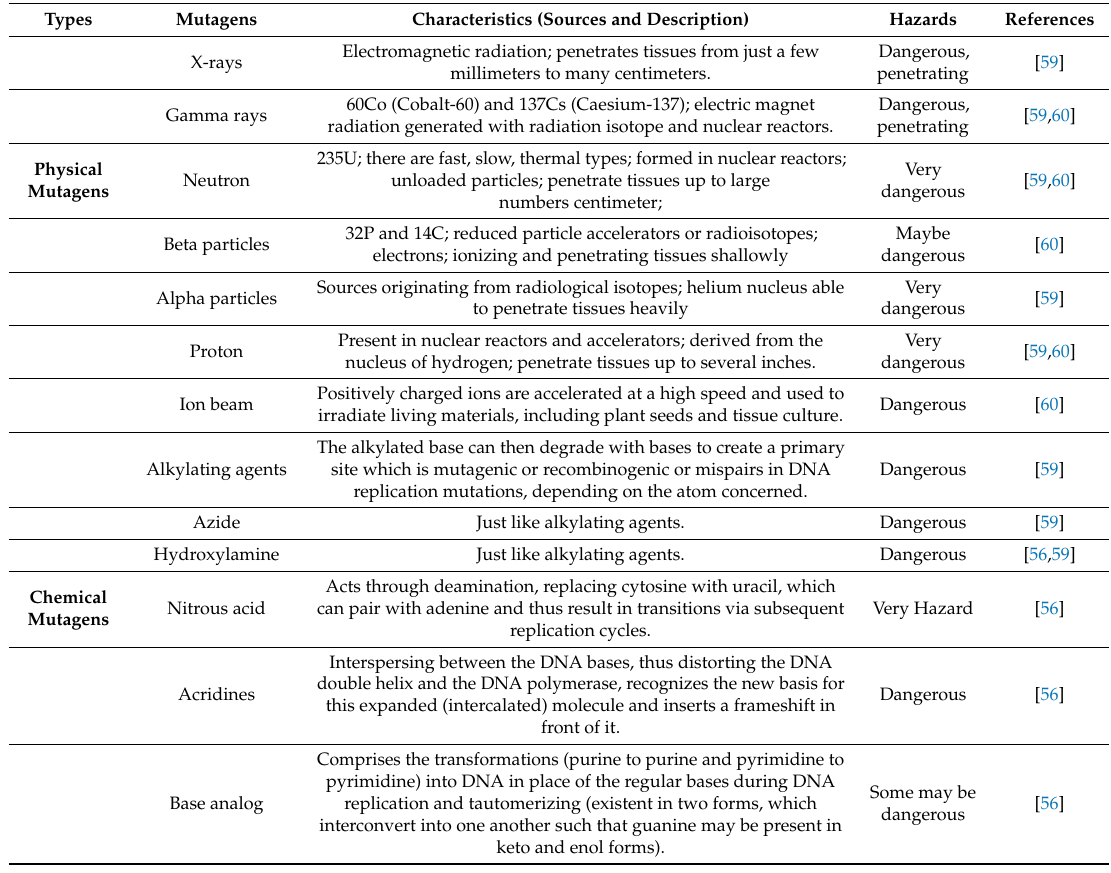
Table 1. Examples of commonly used physical and chemical mutagens, their characteristics, and hazard